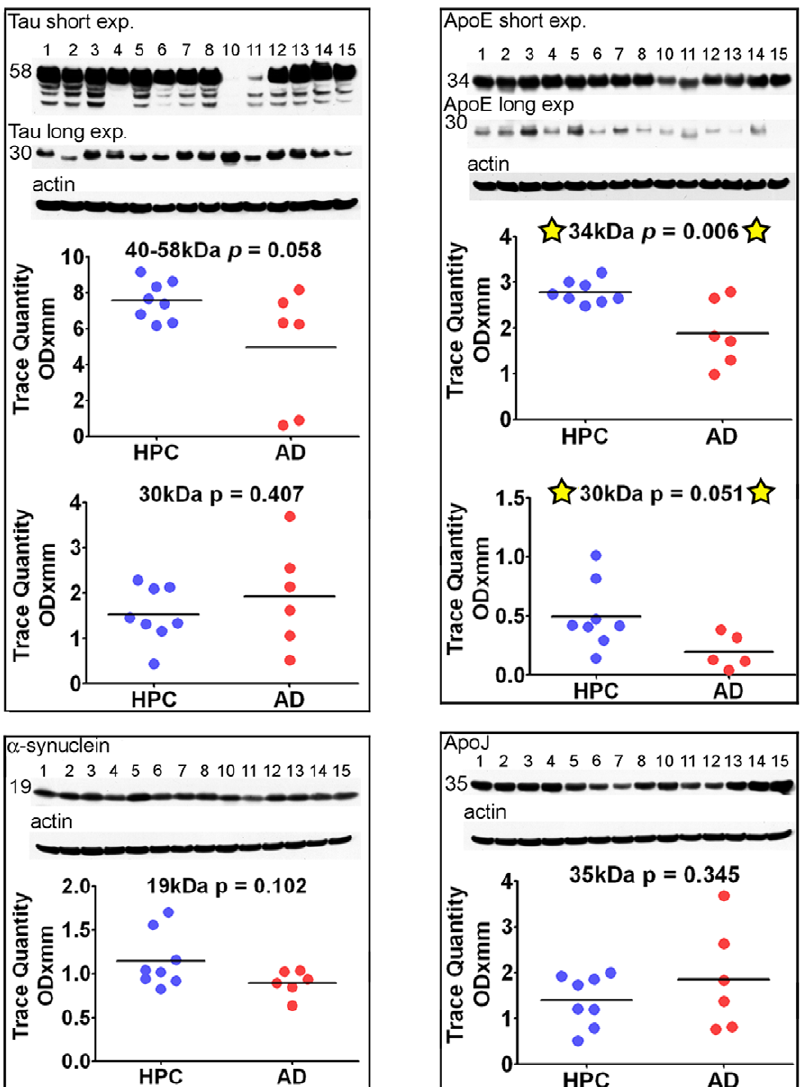
Figure 6. Western blots of tau, ApoE, a -synuclein and ApoJ. A total of 20 m g of total protein was loaded into each lane for the ApoE blot, while all other blots contained 40 m g of total protein. Unpaired, 2-tailed t-tests were used for statistical analysis. The primary and secondary antibody descriptions and sources are given in Table 2 . The relative abundance of the proteins were densitometrically estimated. Each blot was reprobed with actin as a loading control, as shown at the bottom of each primary antibody Western blot. The numbers to the left of the Western blots are the molecular weight in kDa. HPC = non-demented high pathology controls; AD = Alzheimer’s disease; exp = exposure.